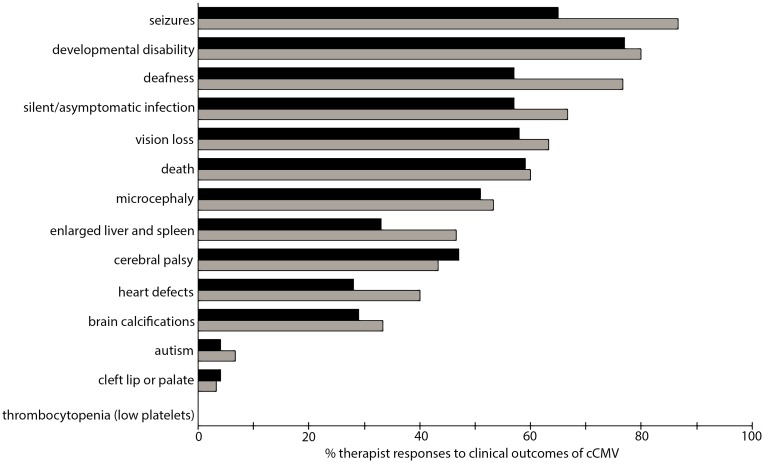
Awareness or knowledge of clinical outcomes of congenital cytomegalovirus (cCMV) amongst physical and occupational therapists.The bars represent percentage of respondents with high SRF (black) and high HRK (grey) who identified each condition as a clinical outcome of cCMV infection. Not all listed conditions are correctly associated with cCMV. No respondents identified thrombocytopenia (low platelets) as a clinical outcome of cCMV. Note that multiple answers were accepted, so the percentages add to more than 100%.